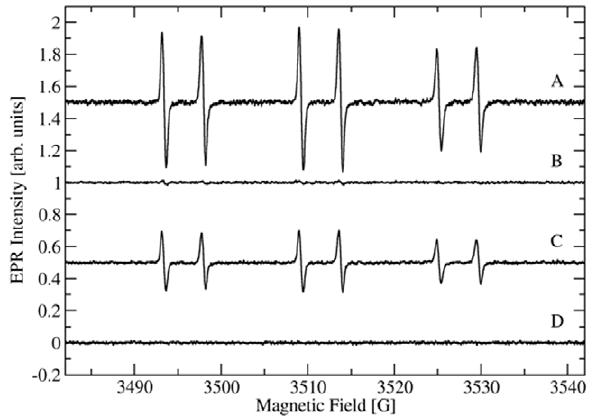
Figure 6. EPR spectra of PBN radical adducts obtained from the incubation of 100 mM oxalate, 100 mM KCl, 20 mM PBN, and 50 m M CsOxOx. (A) PBN-oxalate derived radical adduct from the recombinant, wild type CsOxOx catalyzed reaction. (B) PBN-oxalate derived radical adduct from the CsOxOx A242E mutant catalyzed reaction showed no signal over background. (C) PBN-oxalate derived radical adduct from the CsOxOx D241A mutant catalyzed reaction. (D) All reaction components without